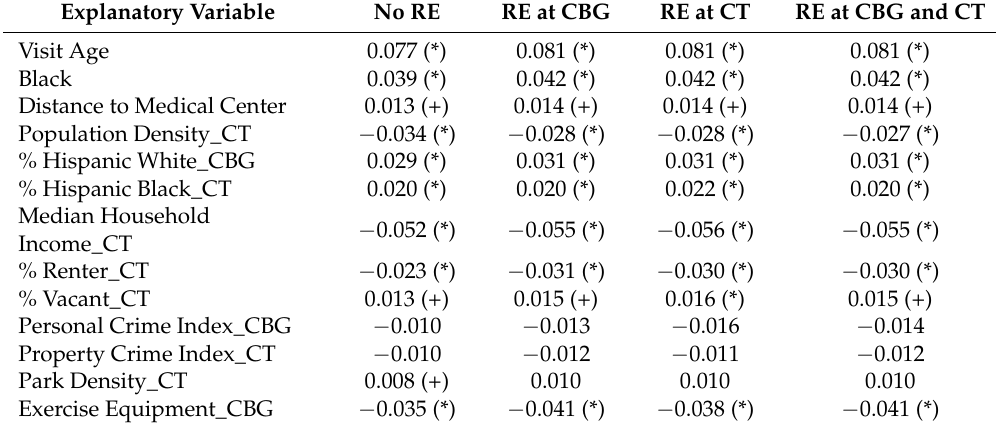
Table 10. Standardized coefficient estimates from the spatial scale (SS) LARS/lasso model of BMI z-scores with no random effect (RE) in comparison to standardized coefficient estimates from three mixed models with a RE at the census block group (CBG), the census tract (CT), and the CBG and CT. The mixed models were fit using the covariates that were chosen by the SS LARS/lasso algorithm. The horizontal dashed line separates the individual-level variables and the neighborhood-level variables considered at multiple spatial scales. Explanatory Variable No RE RE at CBG RE at CT RE at CBG and CT 0.077 (*)